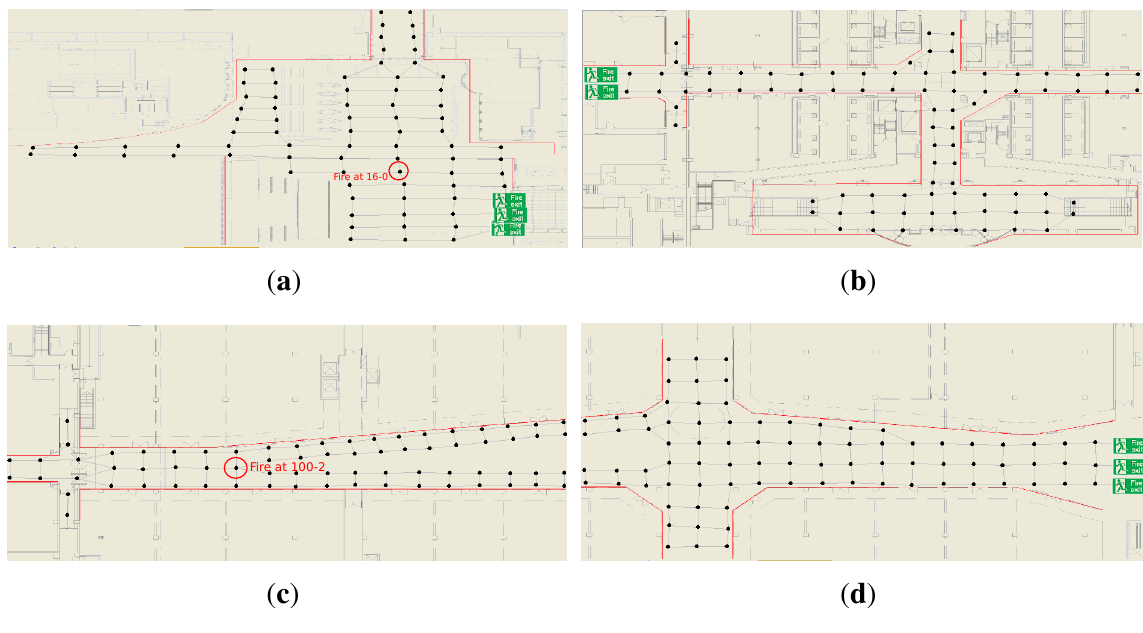
Figure 3. A single-story building used in simulation. The layout parts are connected to each other through the hallways. The string positions of the fire could be seen at ( a ) and ( c ) subfigure. ( a ) The first part of the layout; ( b ) The first second of the layout; ( c ) The third part of the layout; ( d ) The fourth part of the